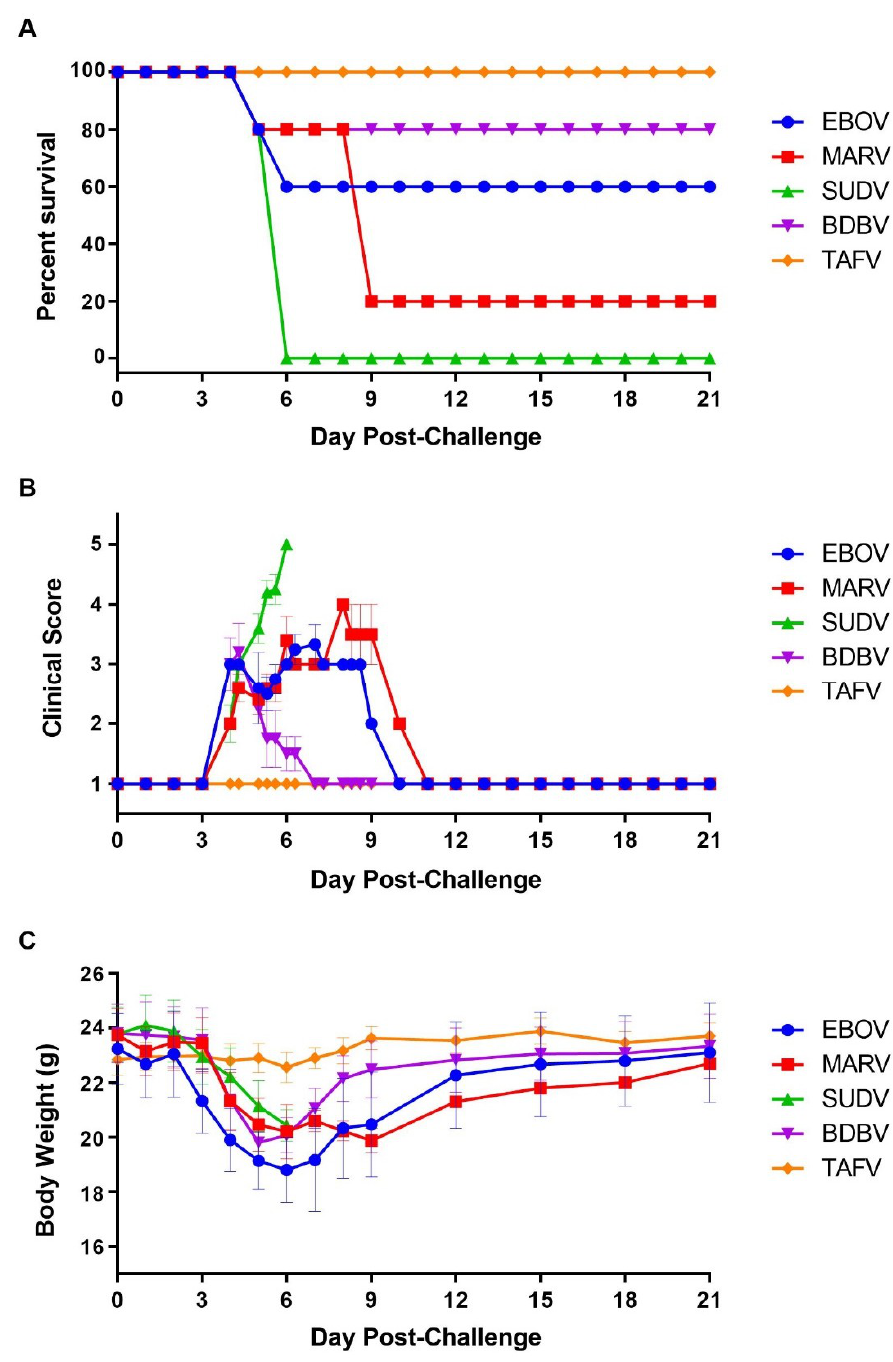
Figure 1. Screening of STAT-1 KO Mice for Susceptibility to Wild-type Filoviruses. Mice (N = 5) were challenged with a targeted dose of 1.0 × 10 4 pfu and observed for up to 21 days for survival ( A ), clinical presentation of disease ( B ), and body weight loss ( C ). Symbols represent group mean clinical scores ( B ) or body weights ( C ); bars indicate standard error.